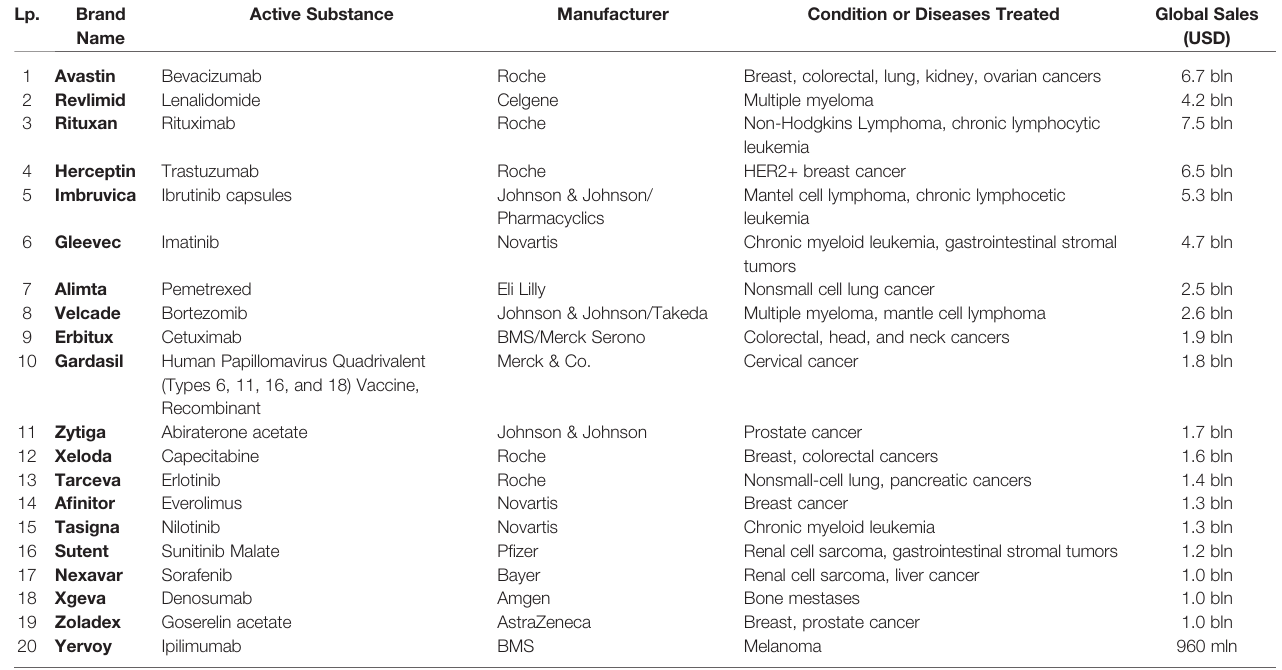
TABLE 3 | Top 20 International blockbuster cancer drugs in 2018, [USD].